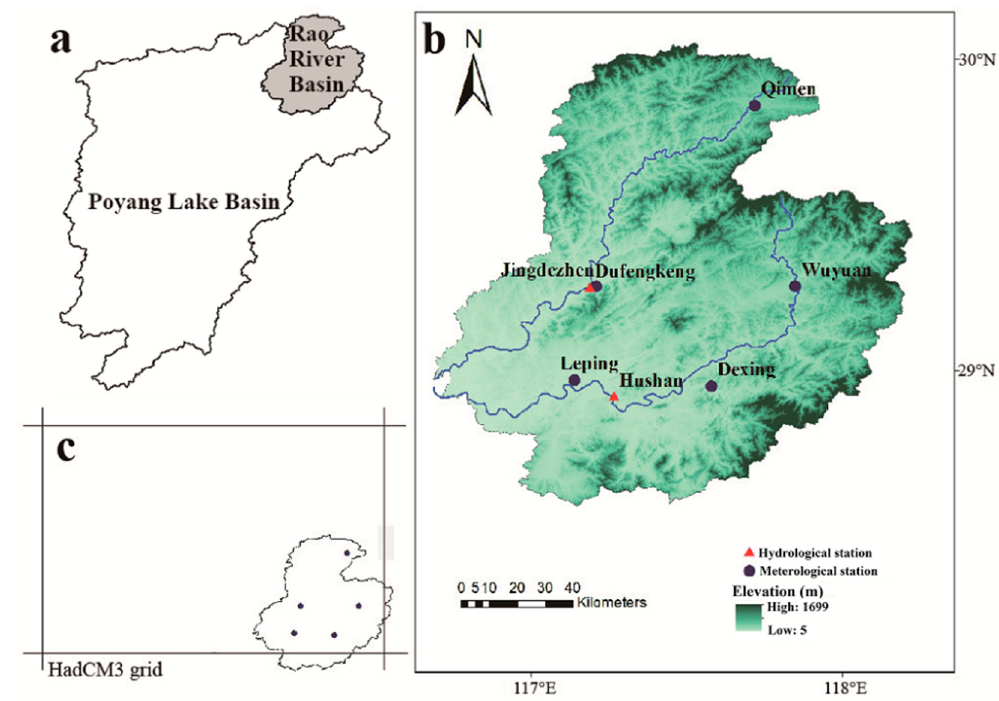
Figure 1. ( a ) Location of the Rao River basin. ( b ) Distribution of meteorological and hydrological stations. ( c ) Corresponding HadCM3 grid points of meteorological and hydrological stations.